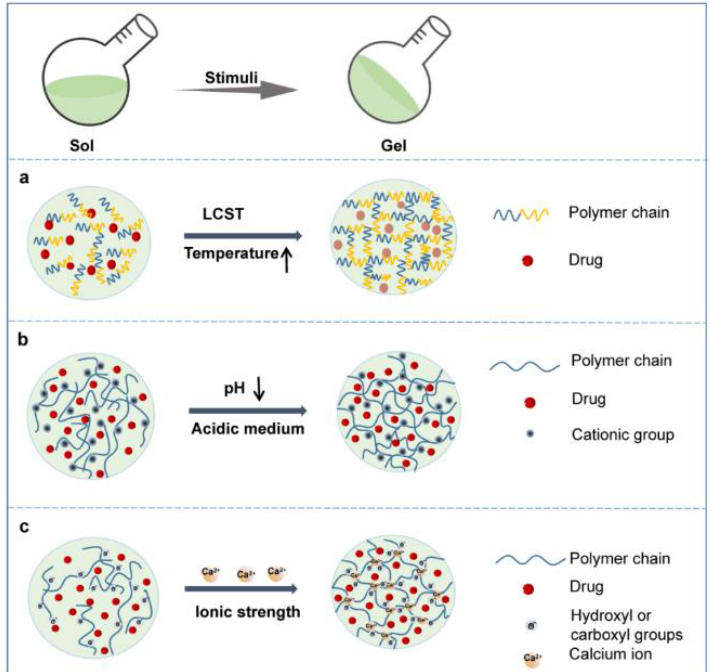
Figure 4. A graphical representation of polymer gels phase transition of representative hydrogels. ( a ) temperature responsive; ( b ) pH responsive; ( c ) tonic strength responsive [64].